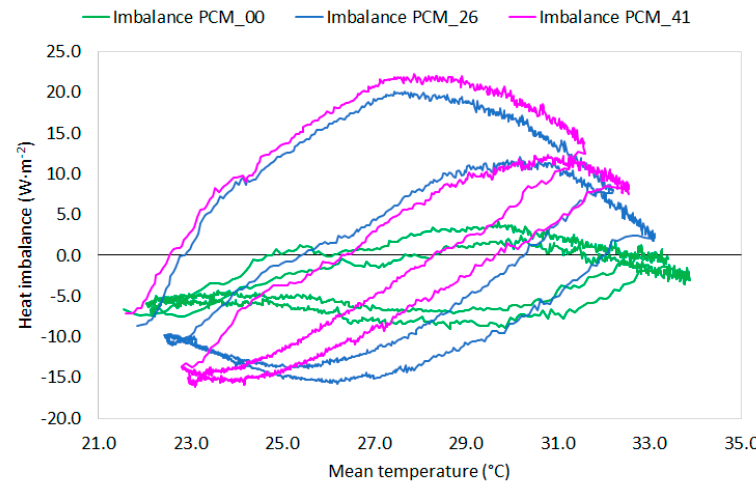
Figure 14. Heat flux imbalance vs the mean temperature of the specimen.